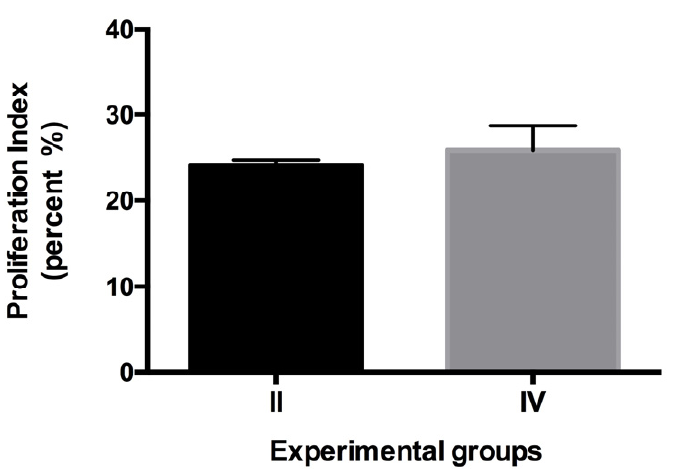
Figure 6. Immune stain for PCNA in lung adenomas. Positive PCNA nuclei (ochre color) were observed in urethane ( A ) and urethane-V ( B ) with no statistical difference between them. Hematoxylin counterstain. Bar 50 µm.